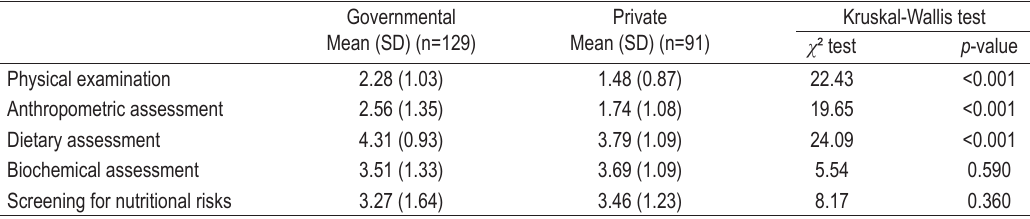
Table 3. Adherence to nutritional assessment